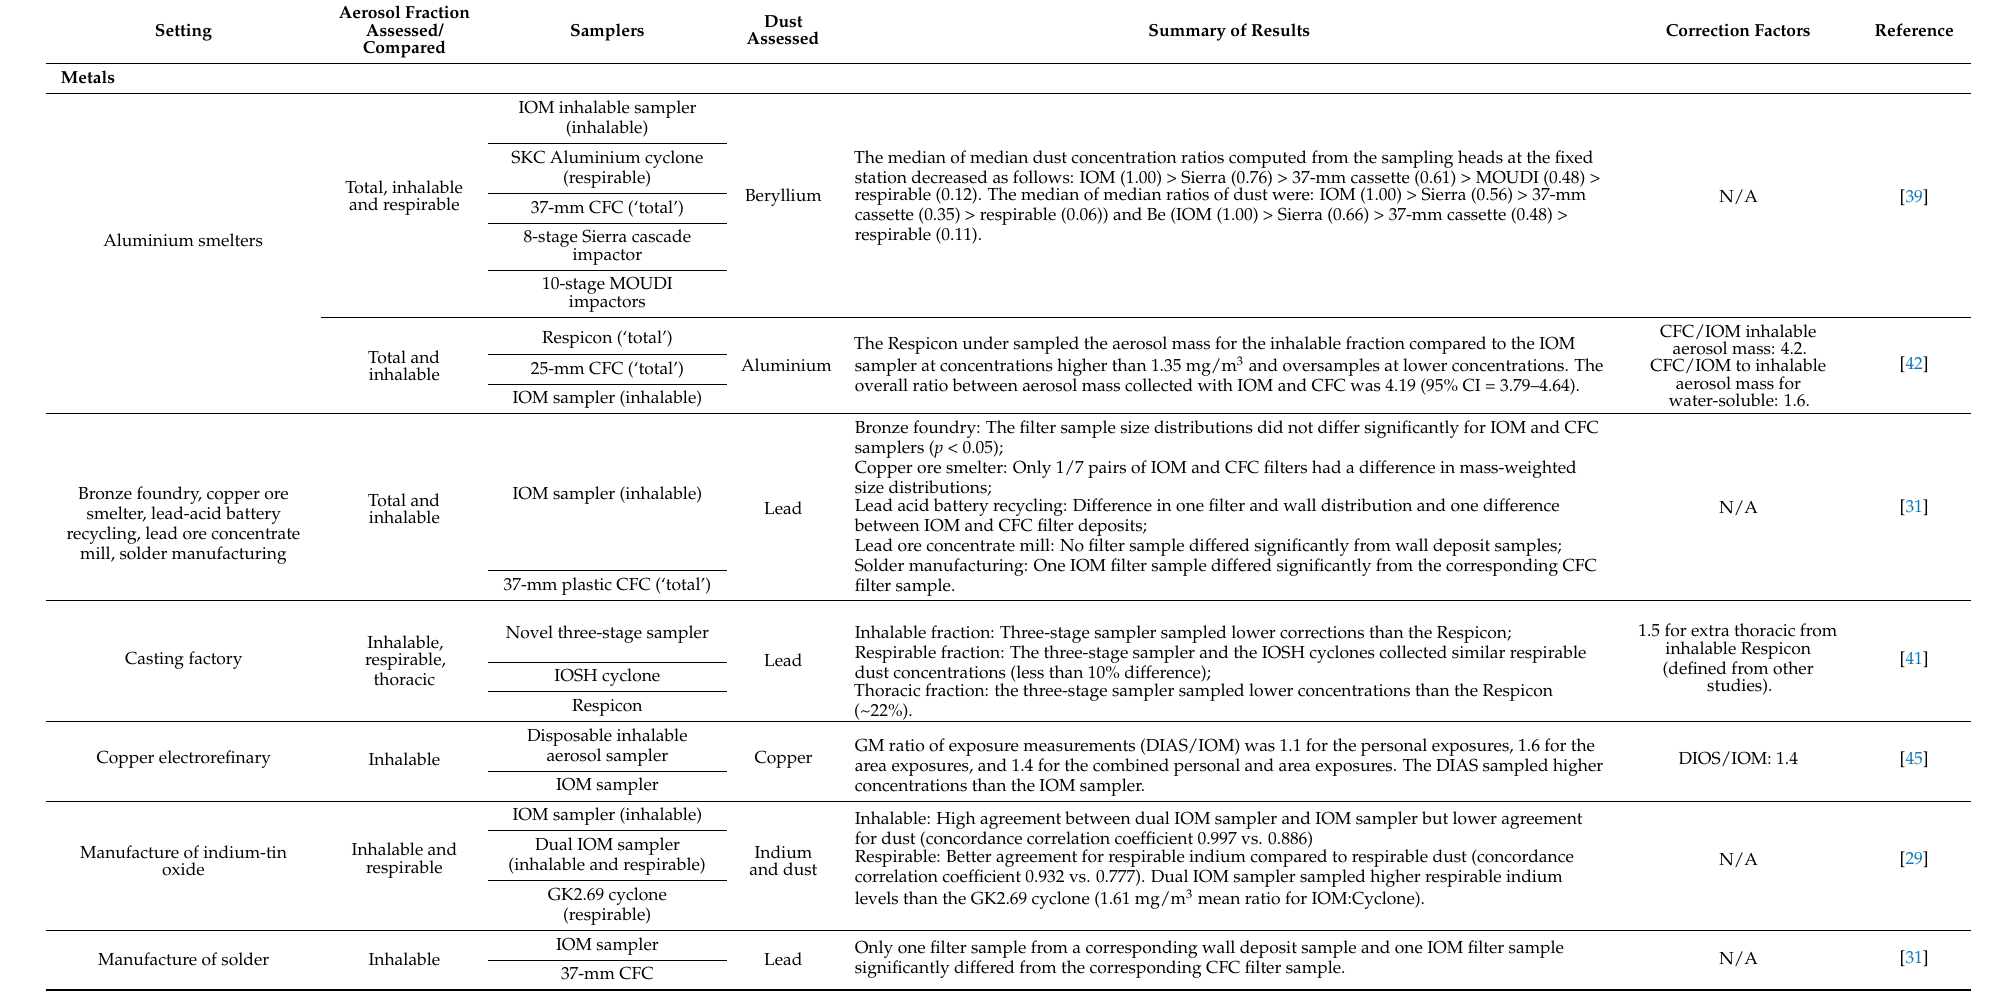
Table 3. Reported results and correction factors for sampler comparison